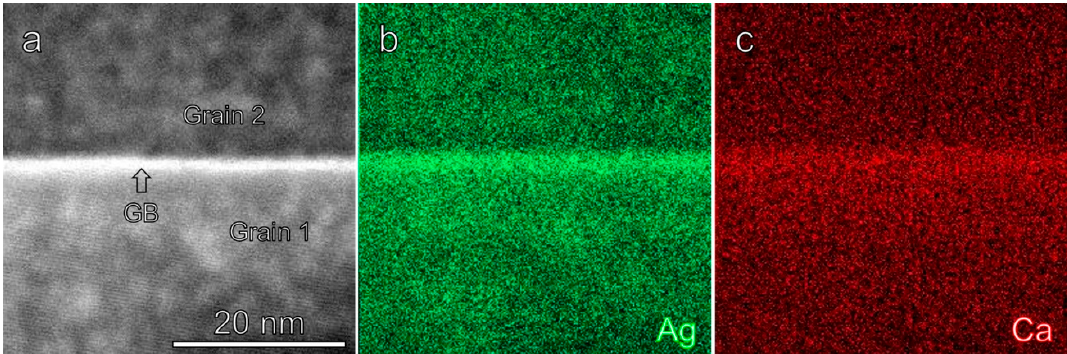
Figure 7. ( a ) High-angle annular dark-field-STEM image and ( b ) Ag and ( c ) Ca elemental maps showing the co-segregation of Ag and Ca atoms along a grain boundary of T4-treated Mg–12Ag–0.1Ca alloy sheet.